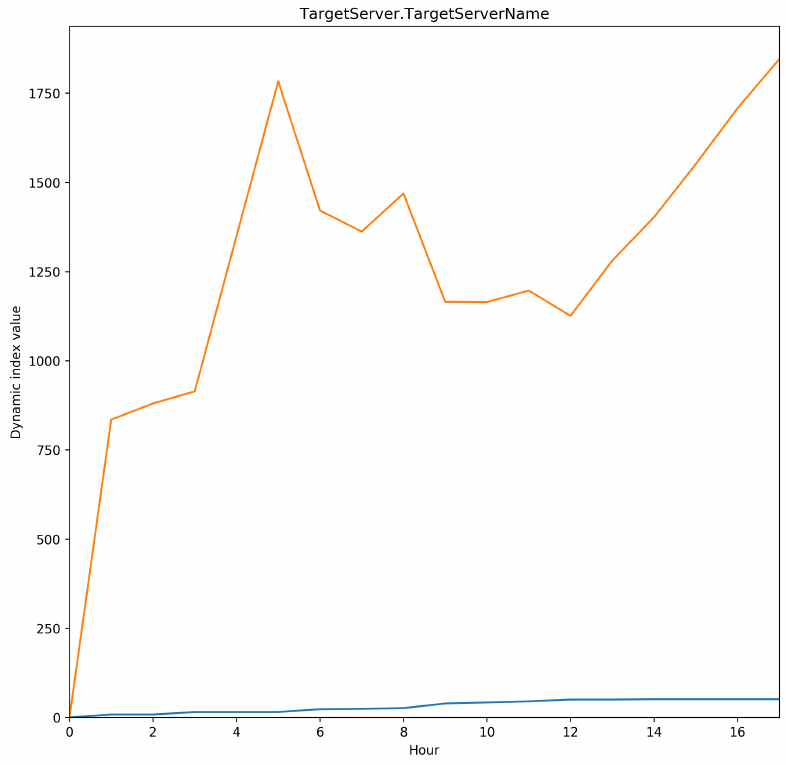
Figure 7. Dynamic indexes for the TargetServer.TargetServerName event